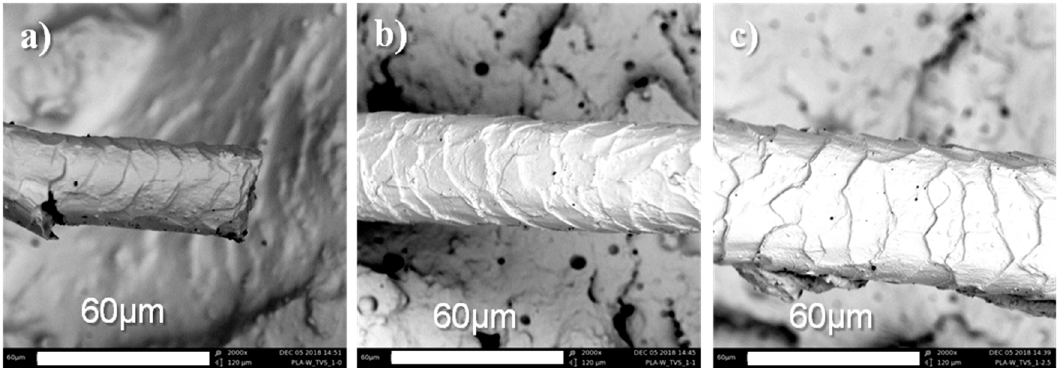
Figure 5. SEM images of ( a ) untreated and silane-treated sheep wool fibers with ( b ) 1 phr of TVS and ( c ) 2.5 phr of TVS.